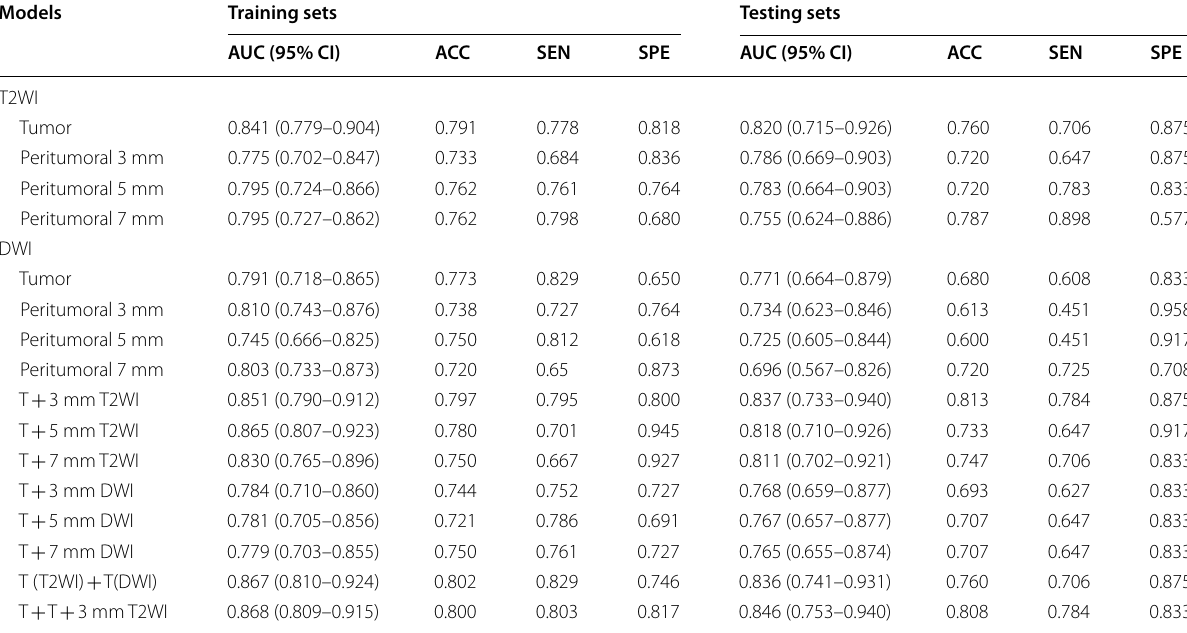
T2WI: T2 weighted imaging; DWI: diffusion-weighted imaging; AUC: area under curer; ACC: accuracy; SEN: sensitivity; SPE: specificity; T x mm expansion;